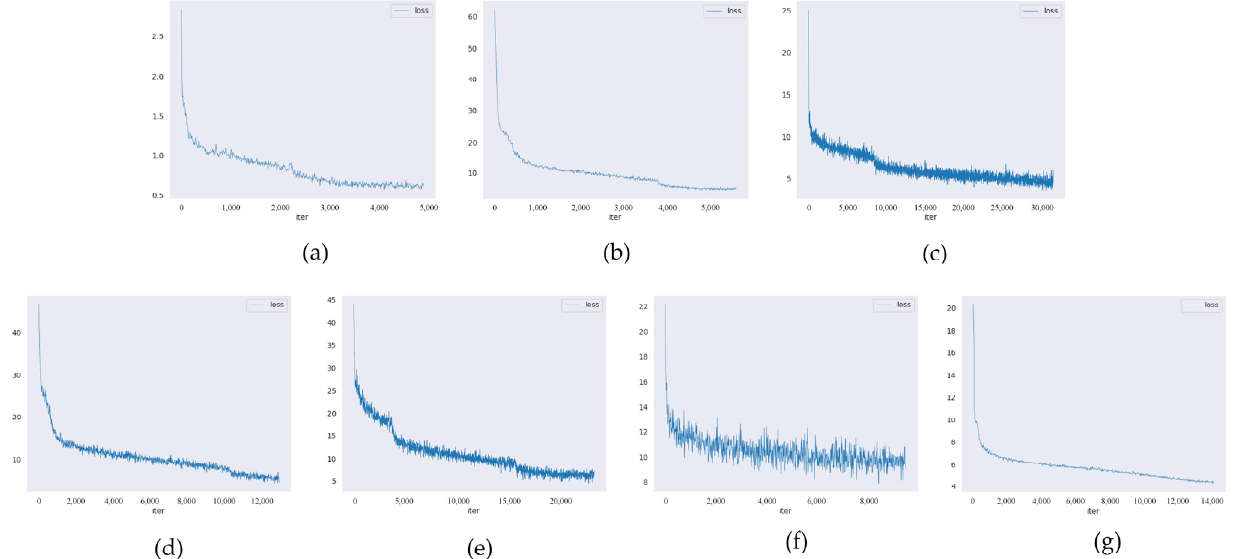
Figure 9. Loss comparison chart of each method. ( a ) Our method:DP-ViT ( b ) Faster R-CNN (Resnet 50) ( c ) Faster R-CNN (Resnet 101) ( d ) Sparse R-CNN (Resnet 50) ( e ) Sparse R-CNN (Resnet 101) ( f ) Next-ViT ( g ) YOLOv3-DPFIN.